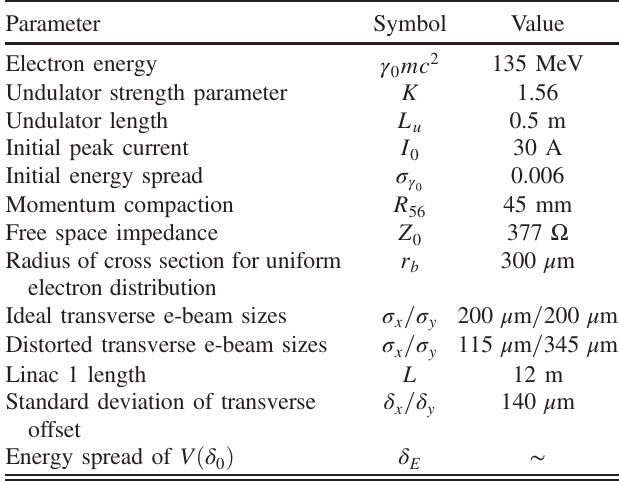
TABLE I. Relevant LCLS parameter